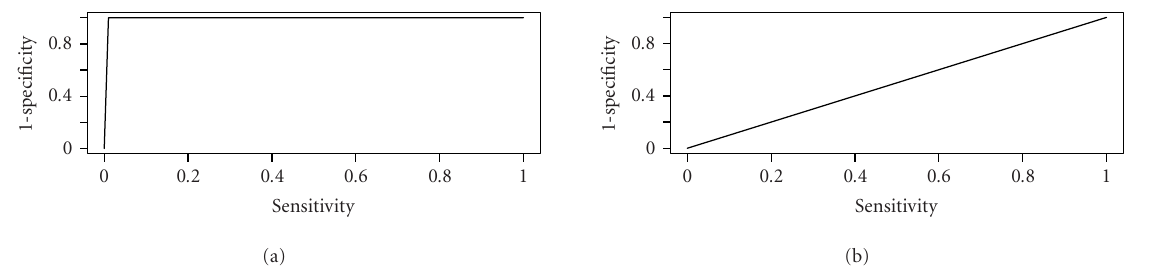
Figure 1. Receiver operating characteristic (ROC) curves for (a) ideal and (b) noninformative tests.